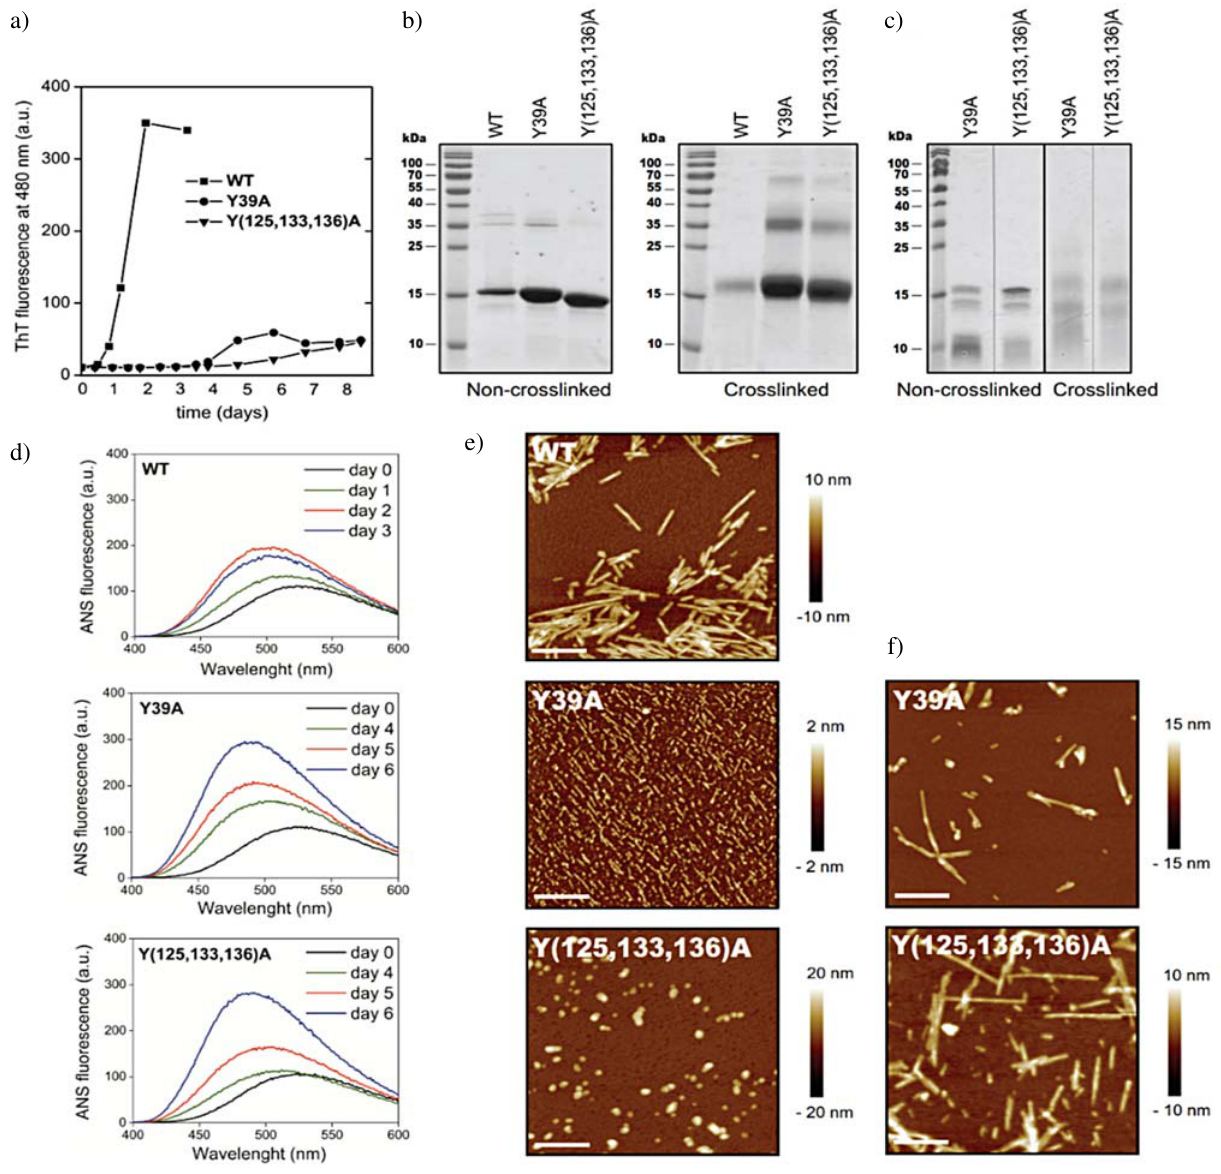
Figure 3. Characterization of the fibrillation of WT α -synuclein and its Tyr mutants. Aliquotes were taken from the incubated protein solutions at distinct times, and subjected to ThT and ANS fluorescence analysis, SDS-PAGE, and AFM imaging. a) Fibrillation kinetics of the proteins, as mo- nitored by ThT fluorescence. (b) SDS-PAGE of non-crosslinked and crosslinked protein supernatant samples after 3 days of incubation. c) SDS- PAGE of non-crosslinked and crosslinked protein supernatant samples after 8 days of incubation. d) ANS emission spectra for the incubated pro- tein mixtures monitored over time. The ANS emission spectra of the mutant proteins over the first 3 days and the last 2 days of incubation showed almost superimposable profiles and were therefore omitted for clarity. e) AFM images of the aggregated proteins after 3 days of incubation. Scale bar, 300 nm. f) AFM images of the aggregated proteins after 8 days of incubation. Scale bar, 300